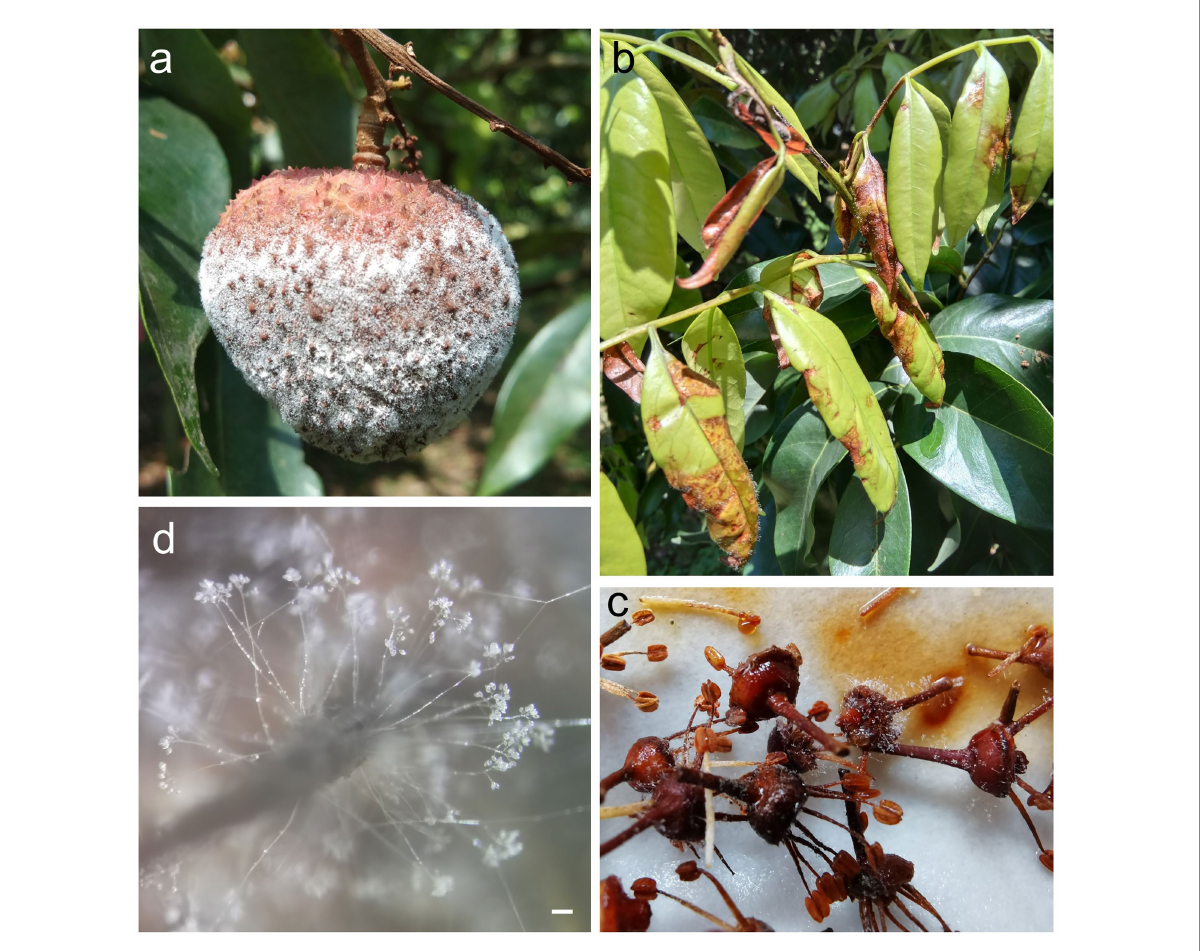
FIGURE 1 Disease symptoms of Peronophythora litchii infection. (A–C) Symptoms of P. litchii on litchi fruit, tender leaves and panicles. (D) Mature sporangiophores and sporangia of P. litchii on the infected tissue. Bar represents 100 μ